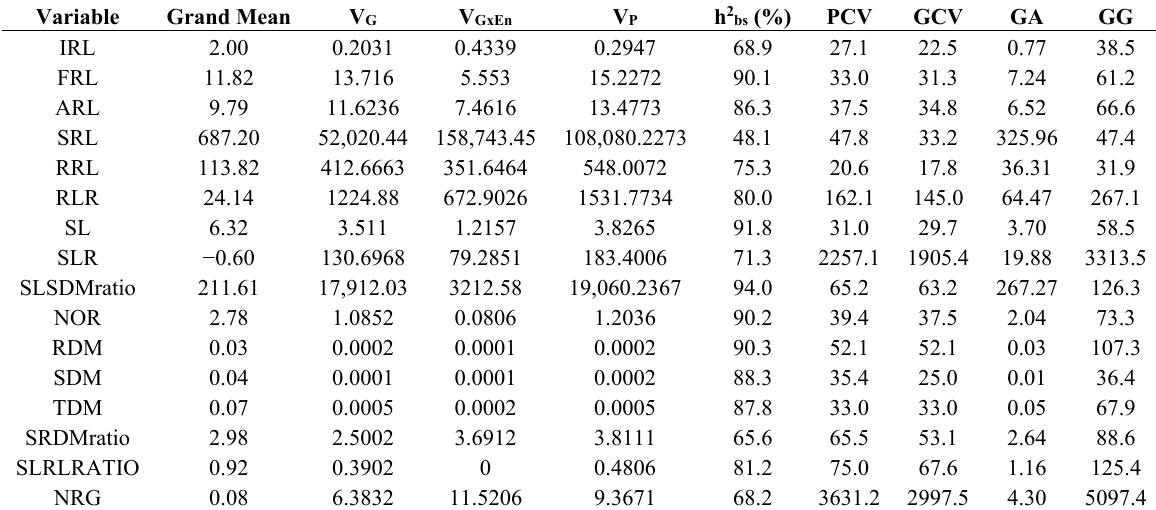
Table 4. Estimates of variance components, heritability, genetic gain, and genetic advance as percent of mean, phenotypic, and genotypic coefficients of variability for 14 inbreds tested in six aluminum concentrations